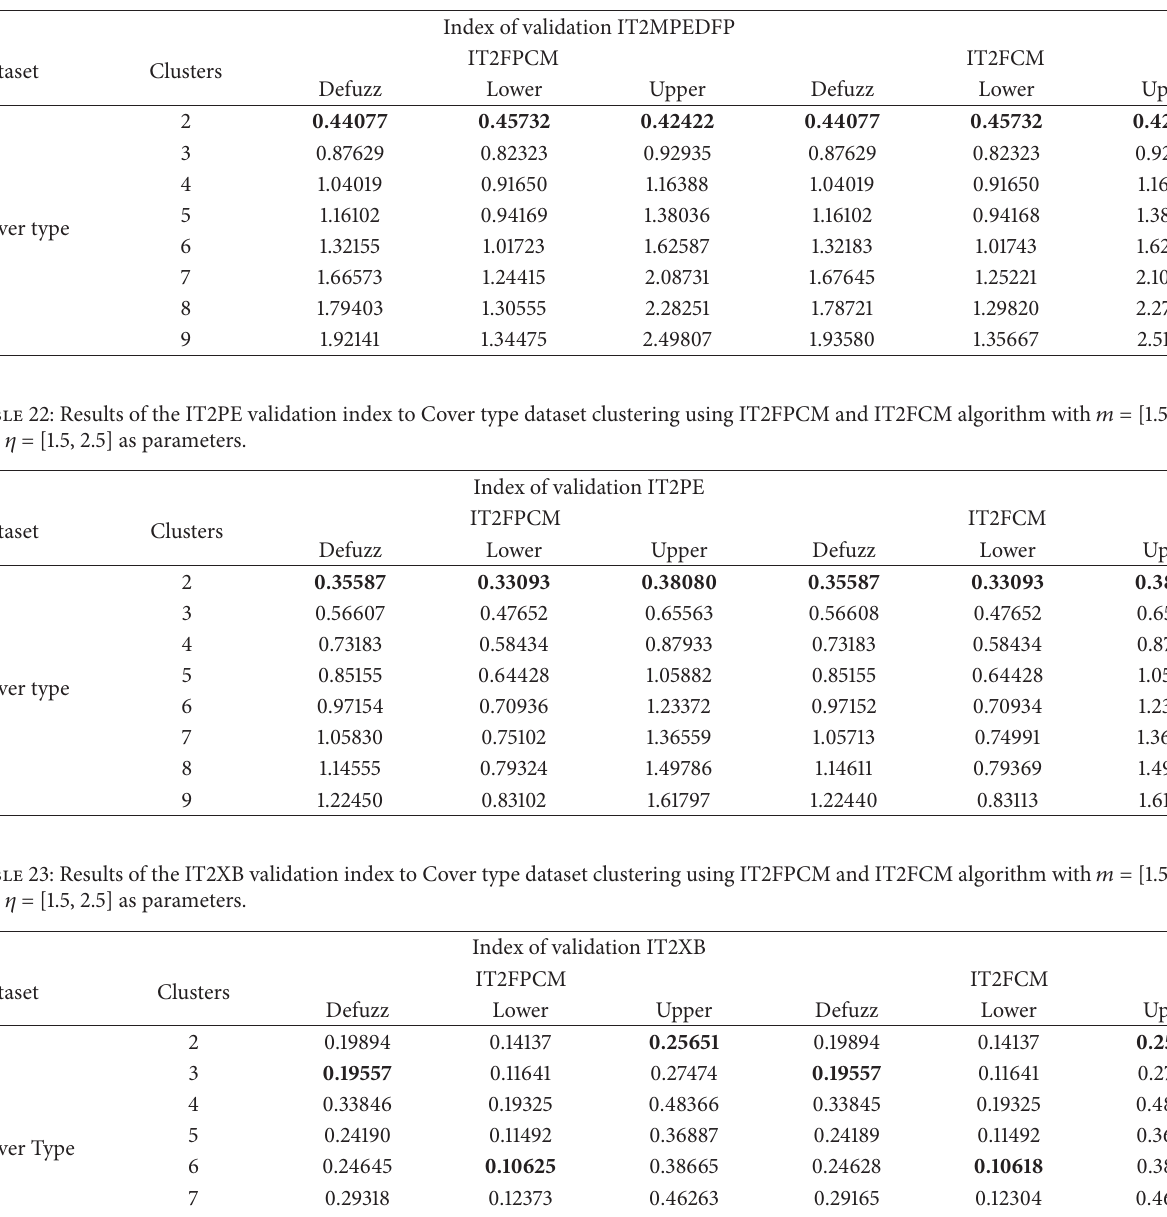
Table 21: IT2MPE-DMFP validation index results to Cover type dataset clustering using IT2FPCM and IT2FCM algorithm with 𝑚 = [1.5, 2.5] and 𝜂 = [1.5, 2.5] as parameters.